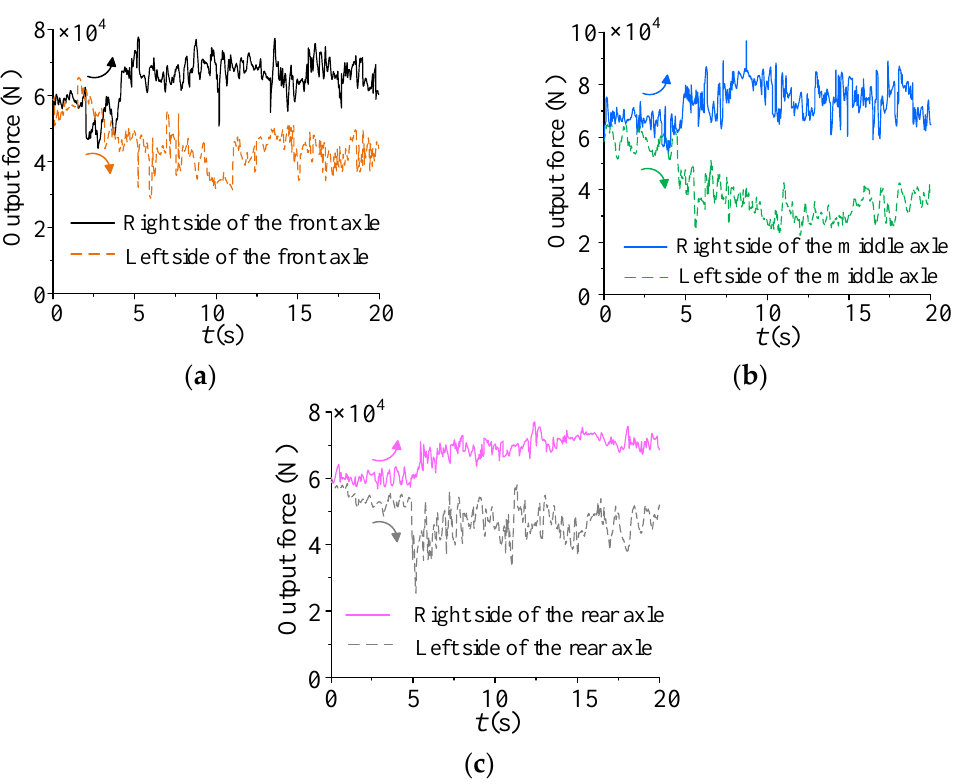
Figure 11. Output force of each actuator under coordination control: ( a ) right side and left side of the front axle; ( b ) right side and left side of the middle axle; ( c ) right side and left side of the rear axle.